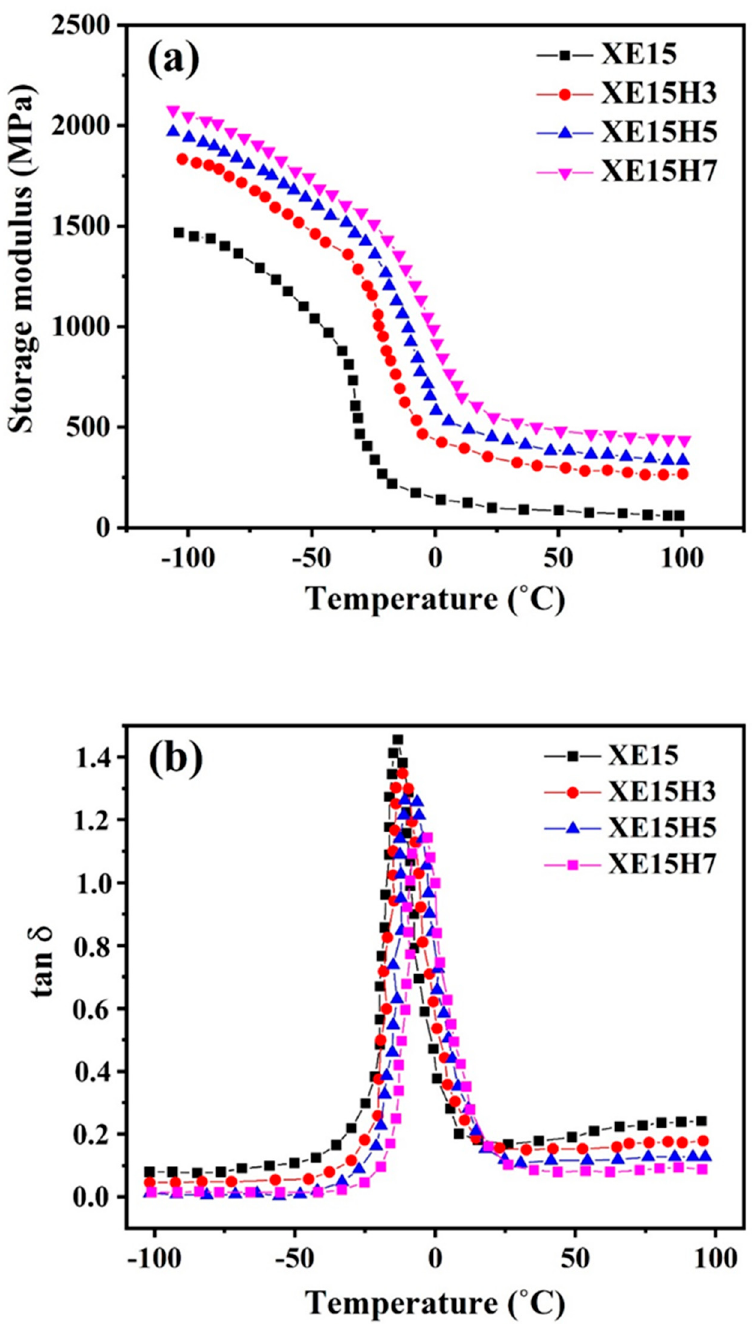
Figure 8. The variations of storage modulus ( a ) and tan δ ( b ) with temperature for various XNBR/epoxy/XHNTs